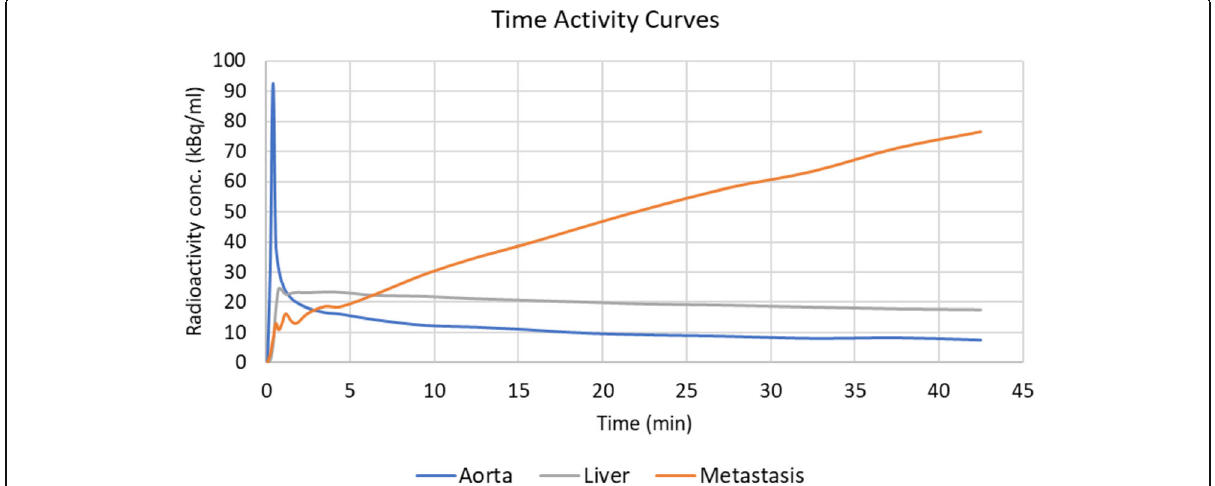
Fig. 2 Time-activity curves obtained from dynamic ABY-025 PET of the aorta, liver, and metastasis in a patient with metastatic breast